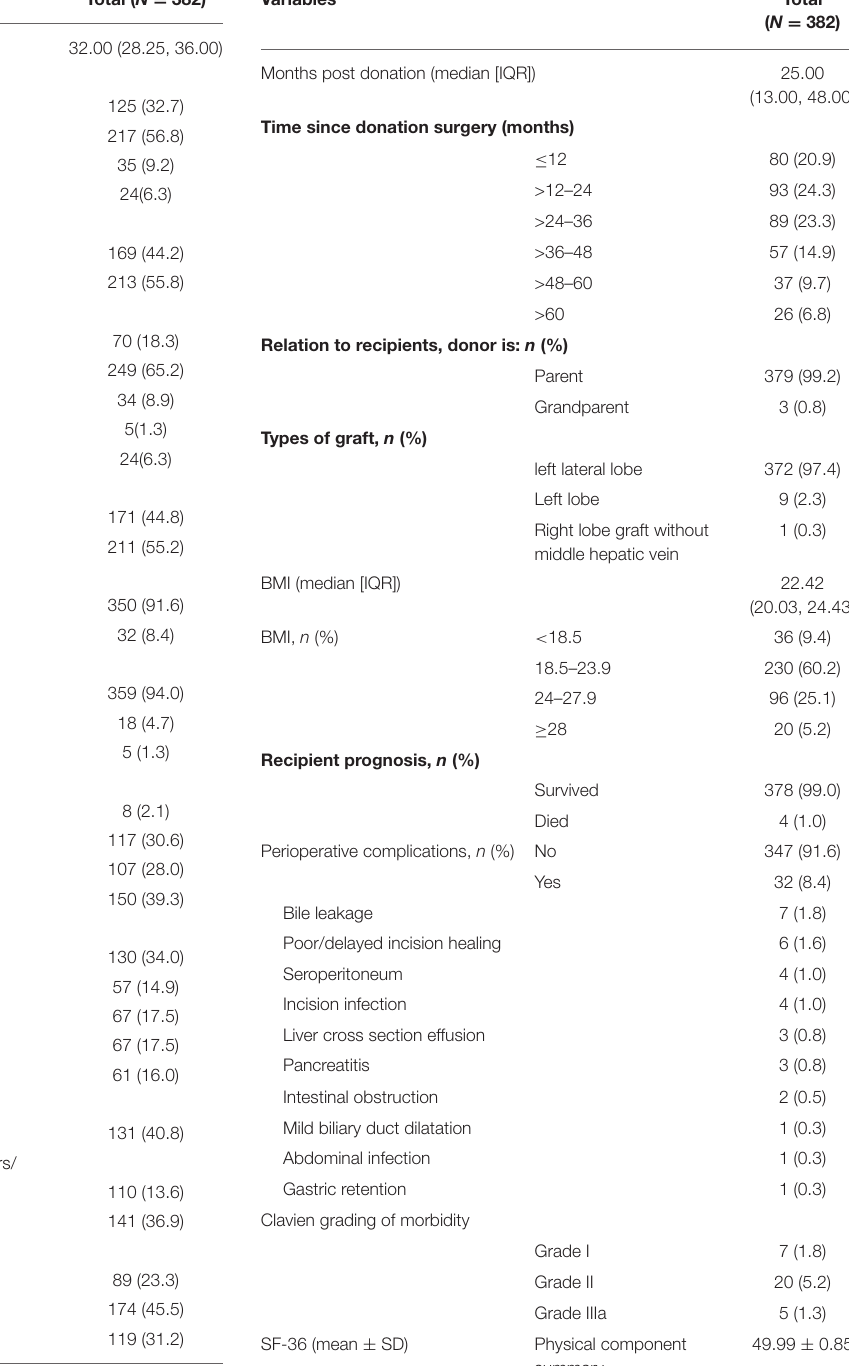
TABLE 1 | Demographic characteristics of living liver donors. TABLE 2 | Clinical characteristics of living liver